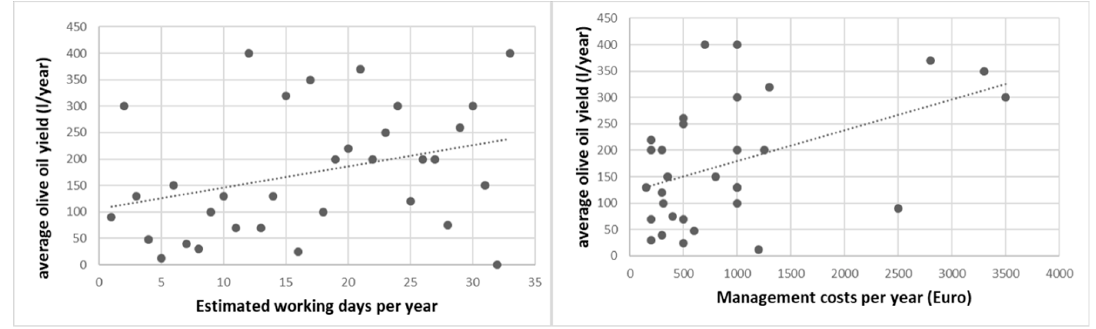
Figure 6. Correlation of management costs and yield ( left ) and between labor input and yield ( right ).